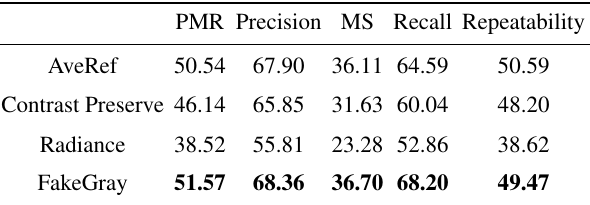
Figure 5. Kernel aensity analysis of 1 & 10 stack points. Blue means there is no keypoints while green represent keypoints. The brighter the color, the more the keypoints. Table 1. Matching Metric for panchromatic keypoints on translation dataset (all data are percentage)